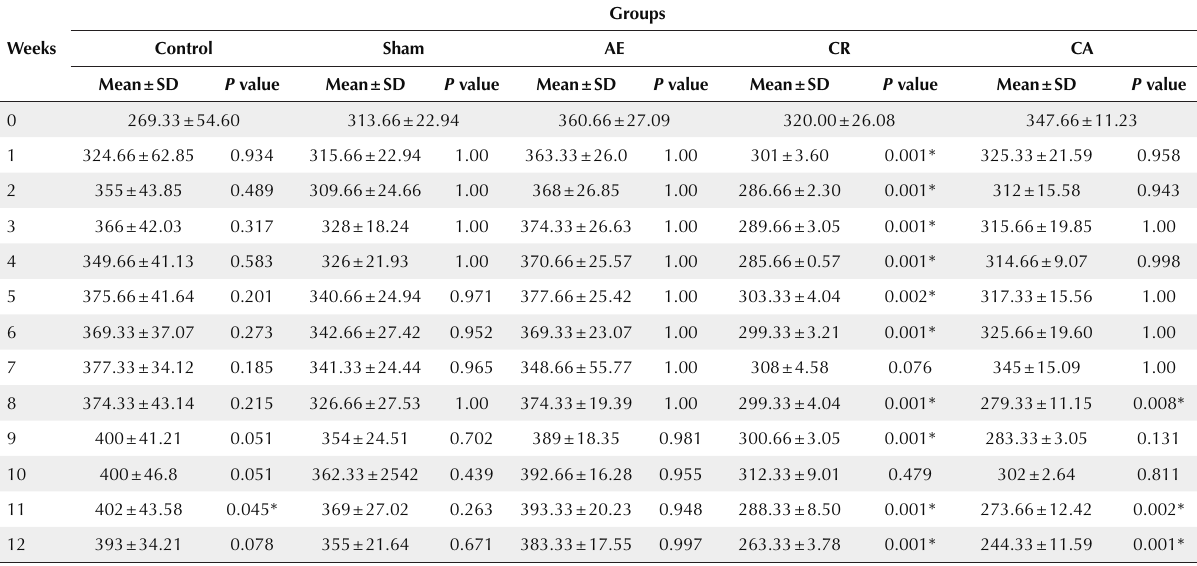
Table 1. Comparison of body weight at the baseline and study interval between the AE, CR, and CA groups Groups Weeks Control Sham AE CR CA Mean ± SD P value Mean ± SD P value Mean ± SD Mean ± SD